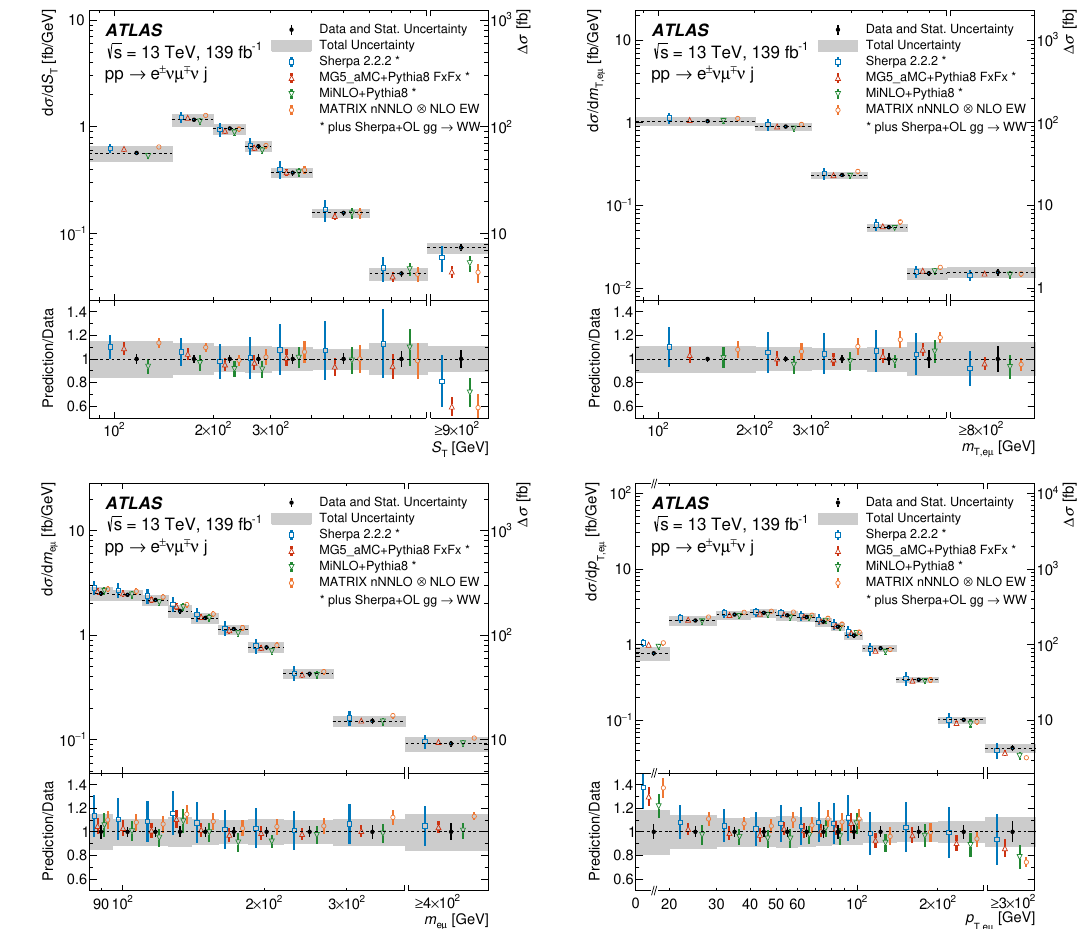
Figure 7 . Measured fiducial cross-sections of WW +jets production for (from left to right and top to bottom): S , m , m , and p . The last bin of each distribution is inclusive in the T T ,eµ eµ T ,eµ measured observable and the corresponding integrated cross-section is indicated by the right-hand- side axis. The measured cross-section values are shown as points with error bars giving the statistical uncertainty and solid bands indicating the size of the total uncertainty. The results are compared with the NNLO prediction with extra NLO EW corrections and NLO corrections for gg → WW production (denoted MATRIX ⊗ NLO EW) as well as NLO+PS predictions from Sherpa 2.2.2, MadGraph5 _a MC@NLO + Pythia 8 with FxFx merging, and Powheg MiNLO + Pythia 8 for q ¯ q initial states, combined with Sherpa + OpenLoops (LO+PS) for the gg initial state. The Sherpa 2.2.2 + OpenLoops prediction is normalized to the total cross-section calculated at NLO in QCD. Theoretical predictions are indicated as markers with vertical lines denoting PDF and scale